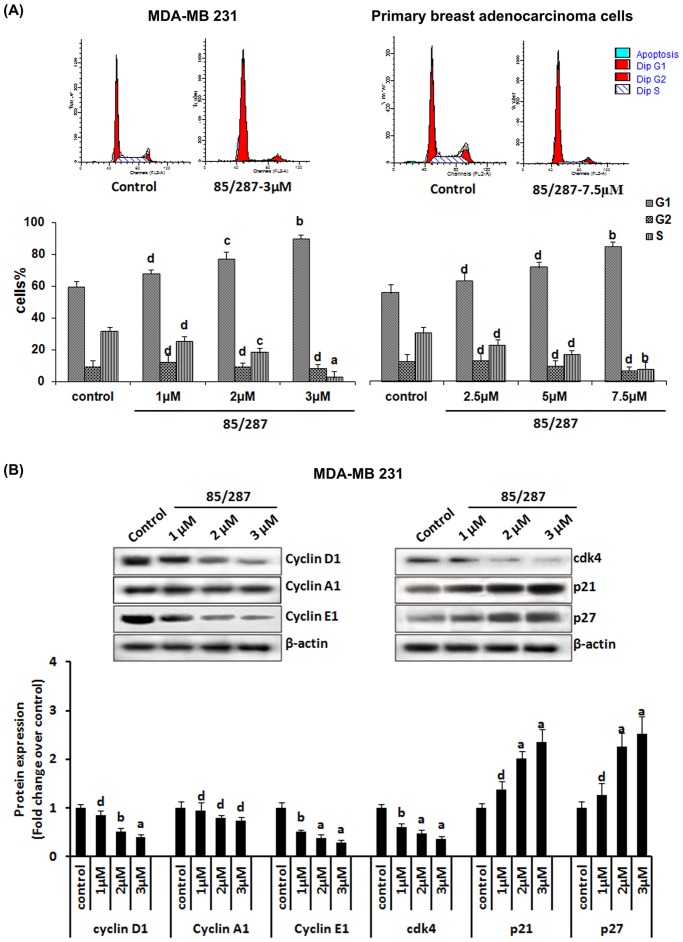
Inhibition of cell cycle progression by CDRI-85/287.(A) Cell cycle analysis by flow cytometry. MDA-MB 231 and primary breast cancer cells were treated with the indicated concentrations of compound for 48h. The cells stained with propidium iodide (PI) were subjected to flow cytometric analysis to determine the percentage of cells at each phase of the cell cycle. Representative images of flow cytometry of vehicle and compound treated cells are shown in the upper panel and the percentage of cell with SEM based on three independent experiments is shown in the lower panel. p values are a-p<0.001, b<0.01, c-p<0.05 and d-p>0.05 vs. control. (B) Western blot analysis to see the expression of cell cycle regulatory proteins cyclin D1, A1, B1, cdk4, p21 and p27. MDA-MB 231 and primary breast cancer cells were treated with the indicated concentrations of compound for 48h and 30 µg whole cell lysate in each lane was probed for the expression of different proteins using specific antibodies. β-actin was used as a control to correct for loading. Representative blots are shown in the upper panel and densitometric quantitation of protein expression levels are shown as fold changes in the lower panel. Results are expressed as mean ± SEM, n = 3. p values are a-p<0.001, b<0.01, c-p<0.05 and d-p>0.05 vs. control.